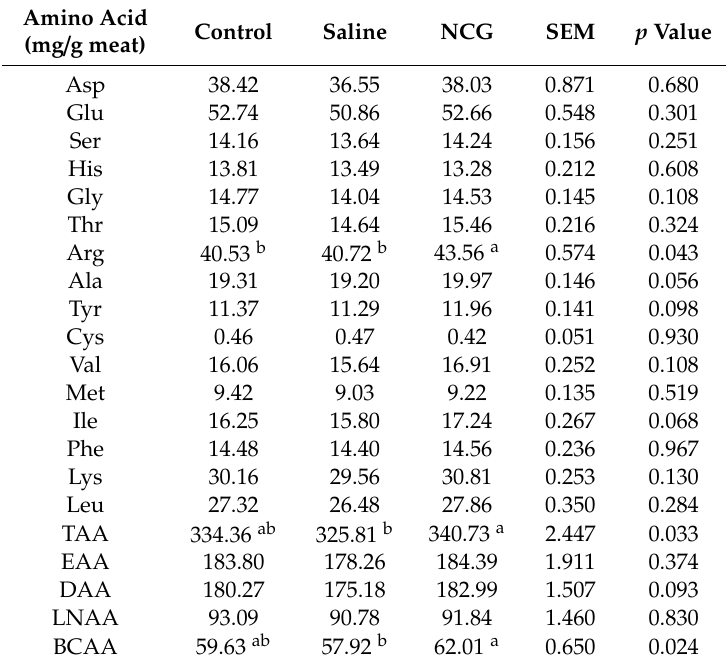
Table 3. Hydrolytic amino acids profile of pectoral muscle in broilers.